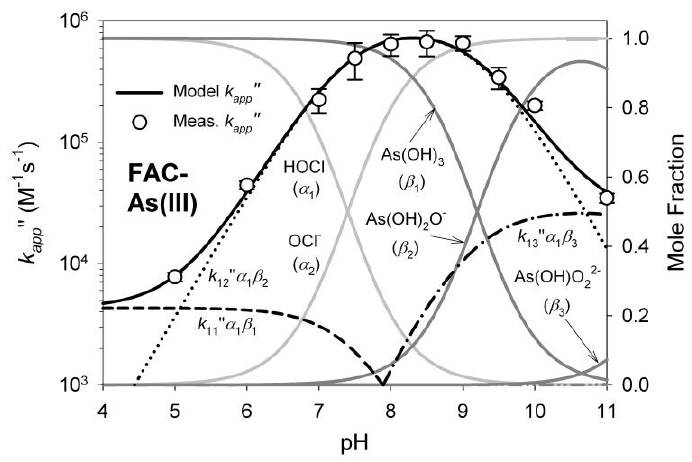
Figure 3. Apparent second-order rate constant for As(III) oxidation by chlorine. Reprinted from [32] with permission from American Chemical Society.